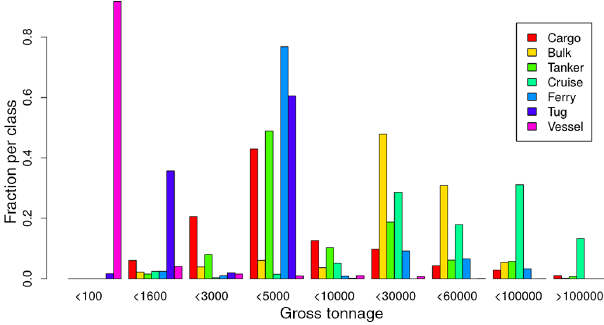
Figure 3. Distribution of ship types across